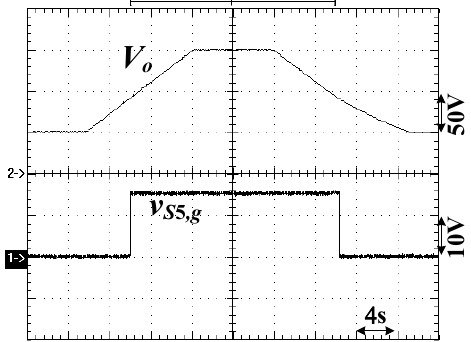
Figure 12. Experiments of V o and I o during output voltage variation between 50 and 160 V.